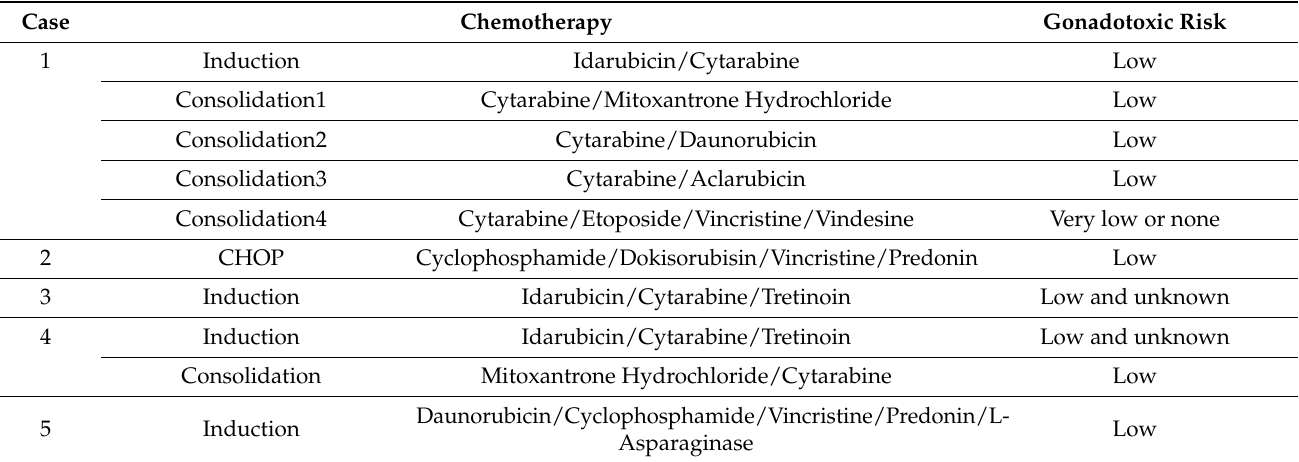
Table 2. Chemotherapy protocols.